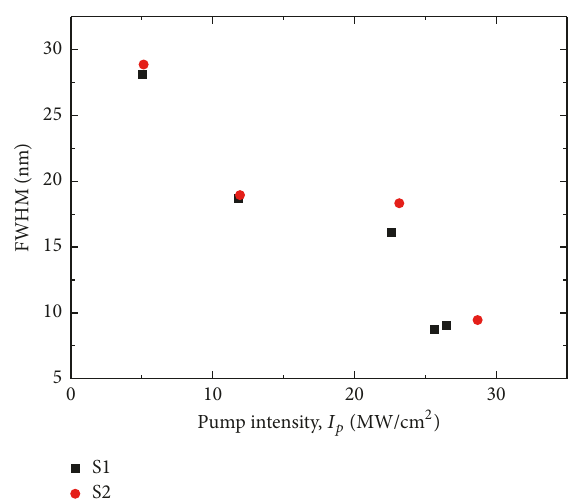
Figure 5: Spectral width at different pump intensities for S1 and